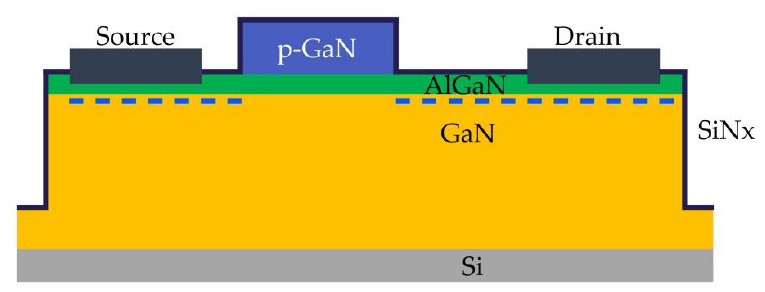
Figure 6. Ohmic contacts structure for source and drain of a p-GaN HEMT.